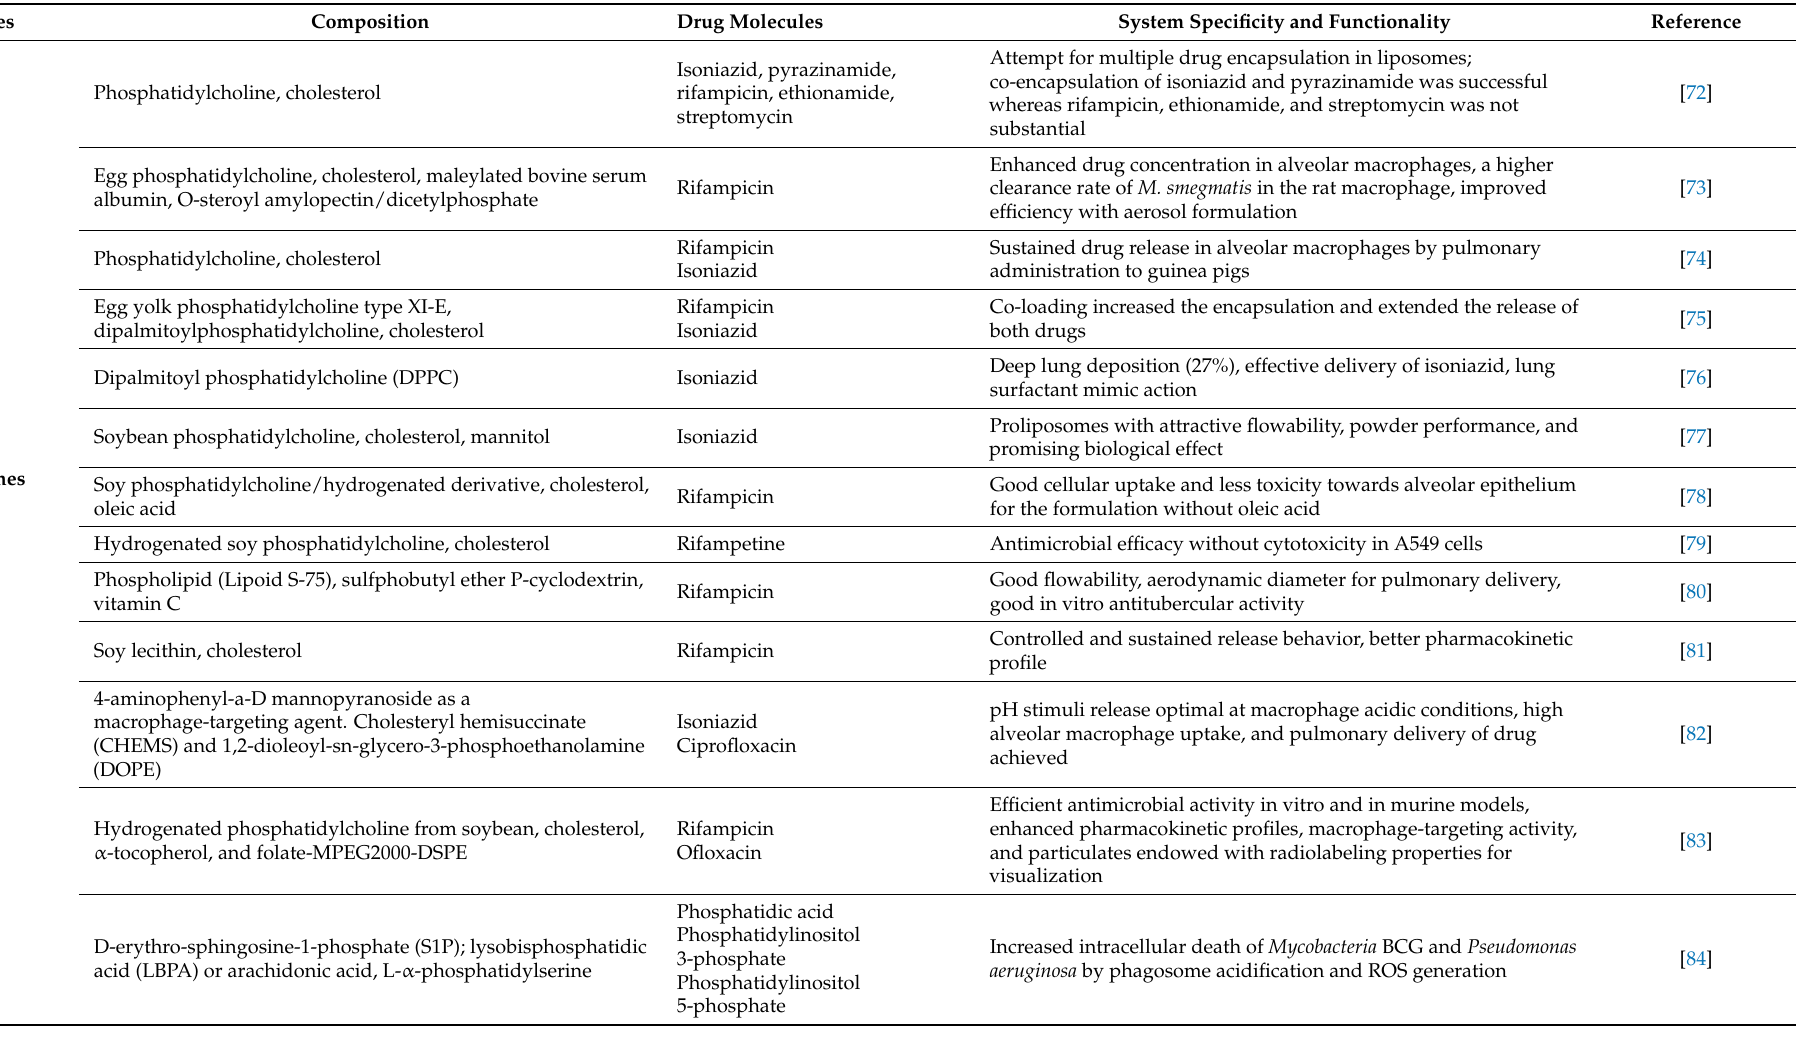
Table 1. Brief presentation of lipid-based formulations investigated for encapsulation and delivery of anti-TB